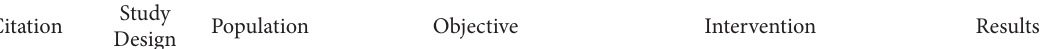
Table 2: Studies evaluating pharmacokinetics in critically ill